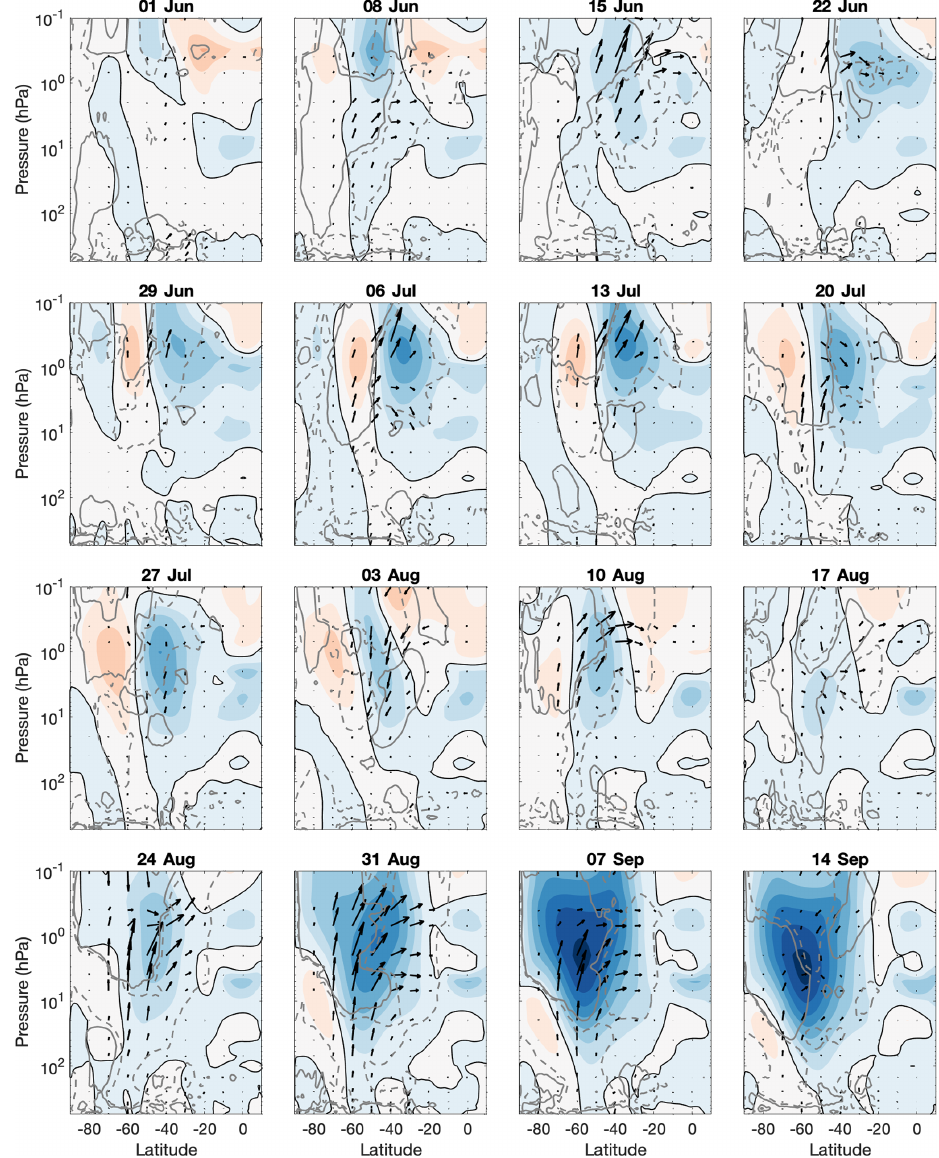
Figure 3. Difference between 2019 and the reference eQBO years. Zonal wind contour intervals, EP-flux vectors, and EP flux divergence (divEP) levels are the same as in Fig.